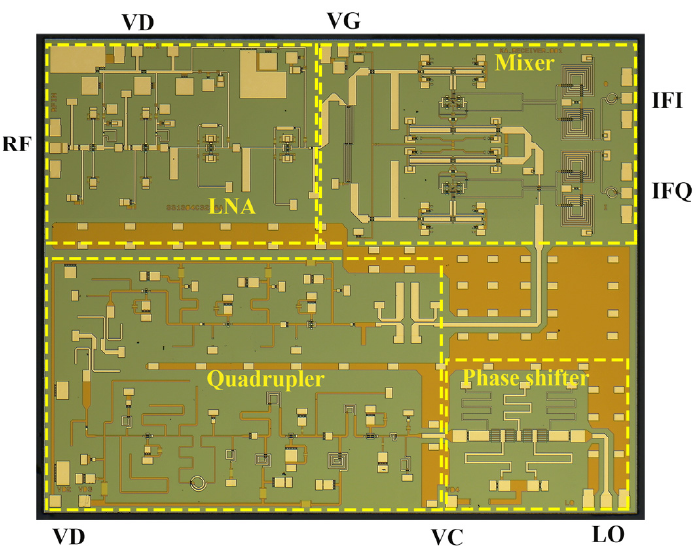
Figure 19. Microphotograph of the fabricated receiver MMIC. The chip size measures 5 × 4 mm 2 .